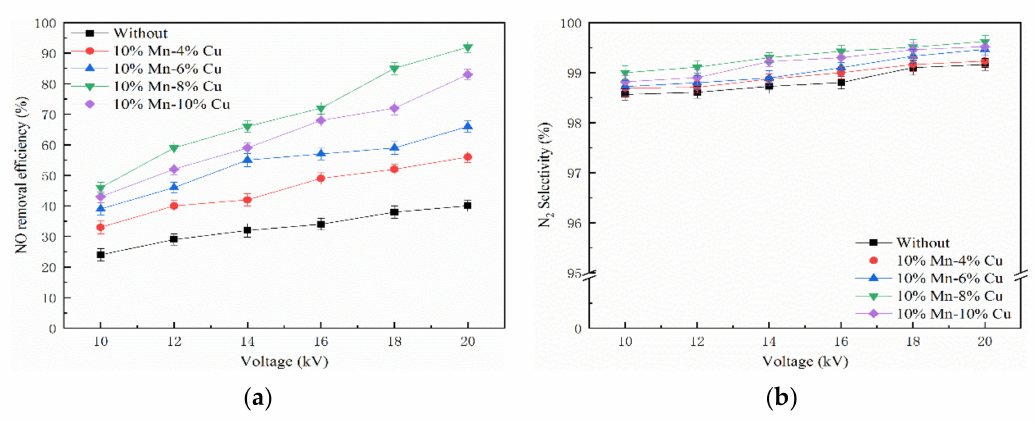
Figure 4. E ff ect of voltage on NO removal e ffi ciency. ( a ) NO removal e ffi ciency and ( b ) N 2 selectivity.